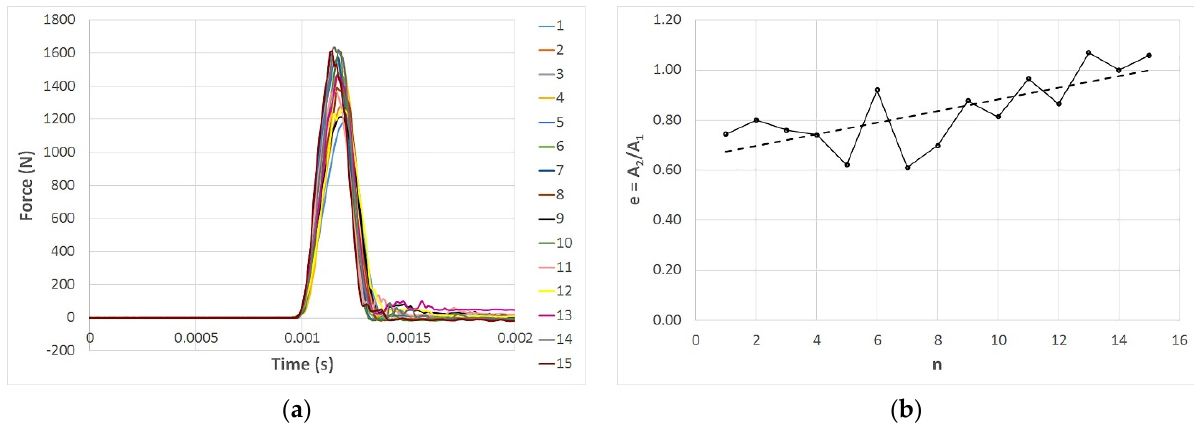
Figure 14. Impact test on stone n. 4: ( a ) time–force diagram of the 15 beats; ( b ) trend of the restitution coefficient ( e ) vs. number of beats ( n ).